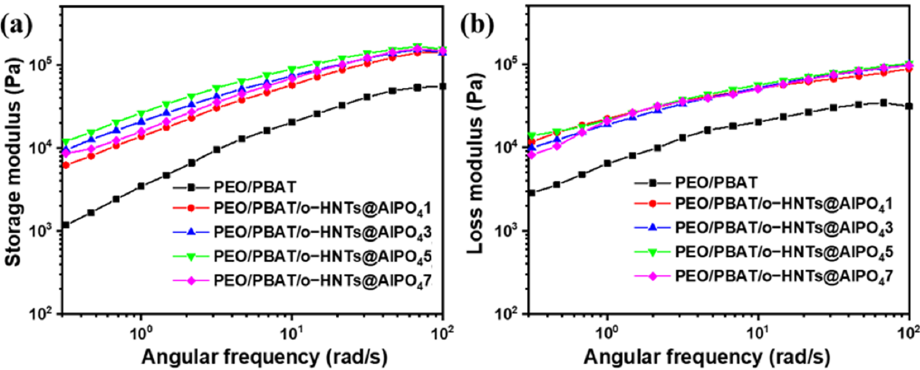
Figure 6. ( a ) The storage modulus and ( b ) loss modulus versus angular frequency for the PEO/PBAT and PEO/PBAT/o-HNTs@AlPO 4 films at 190 °C.